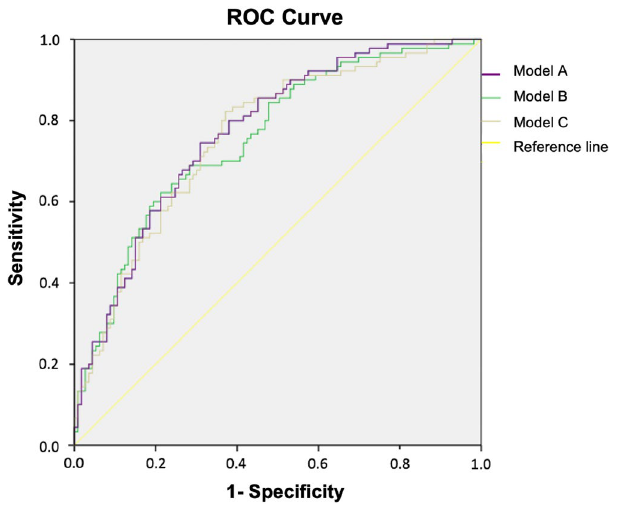
Figure 2. ROC curves for predictive models A, B and